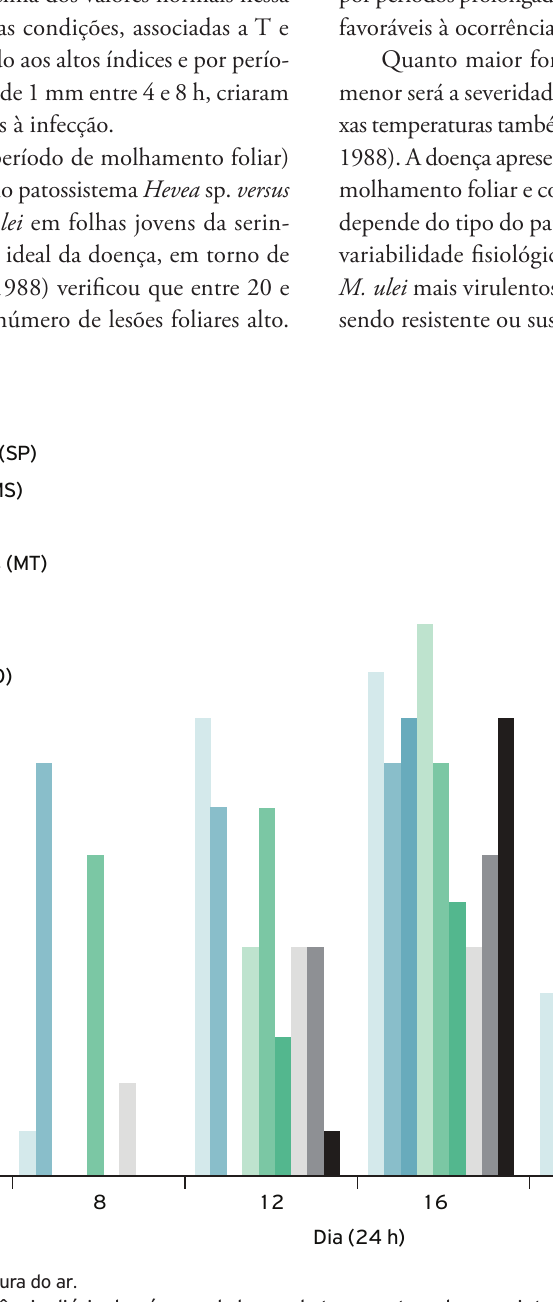
Figura 2. Distribuição da frequência diária do número de horas de temperatura do ar no intervalo entre 20 e 25°C, no período entre 12 de janeiro e 10 de fevereiro de